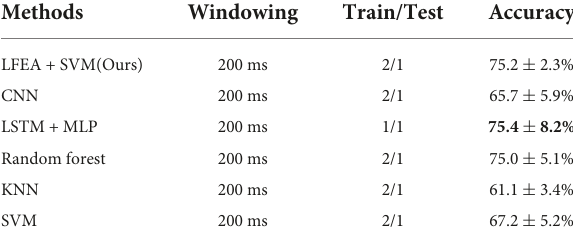
TABLE 4 Classification results on NinaPro DB2 dataset.